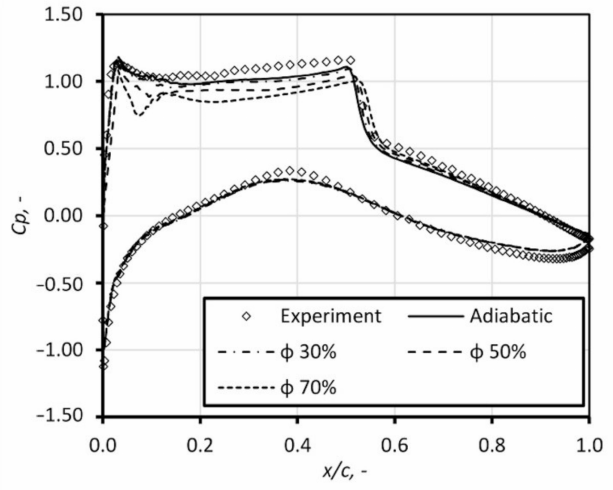
Figure 11. Pressure coe ffi cient distribution on the airfoil for dry and humid airflow for total temperature of 282